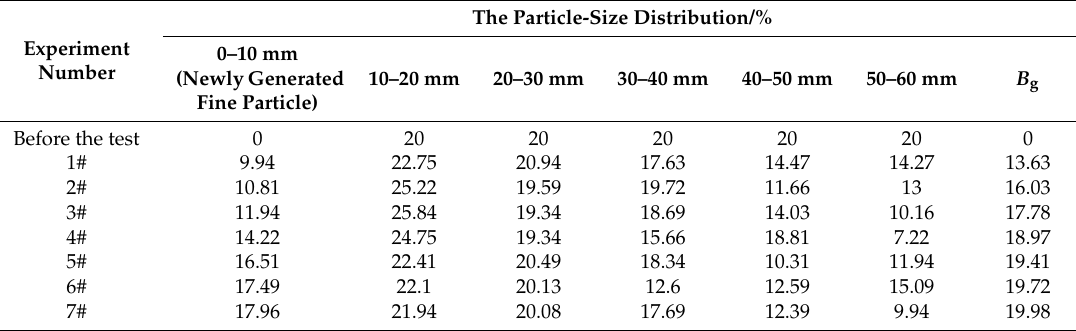
Table 2. The particle-size distribution and the particle-crushing ratio ( B g